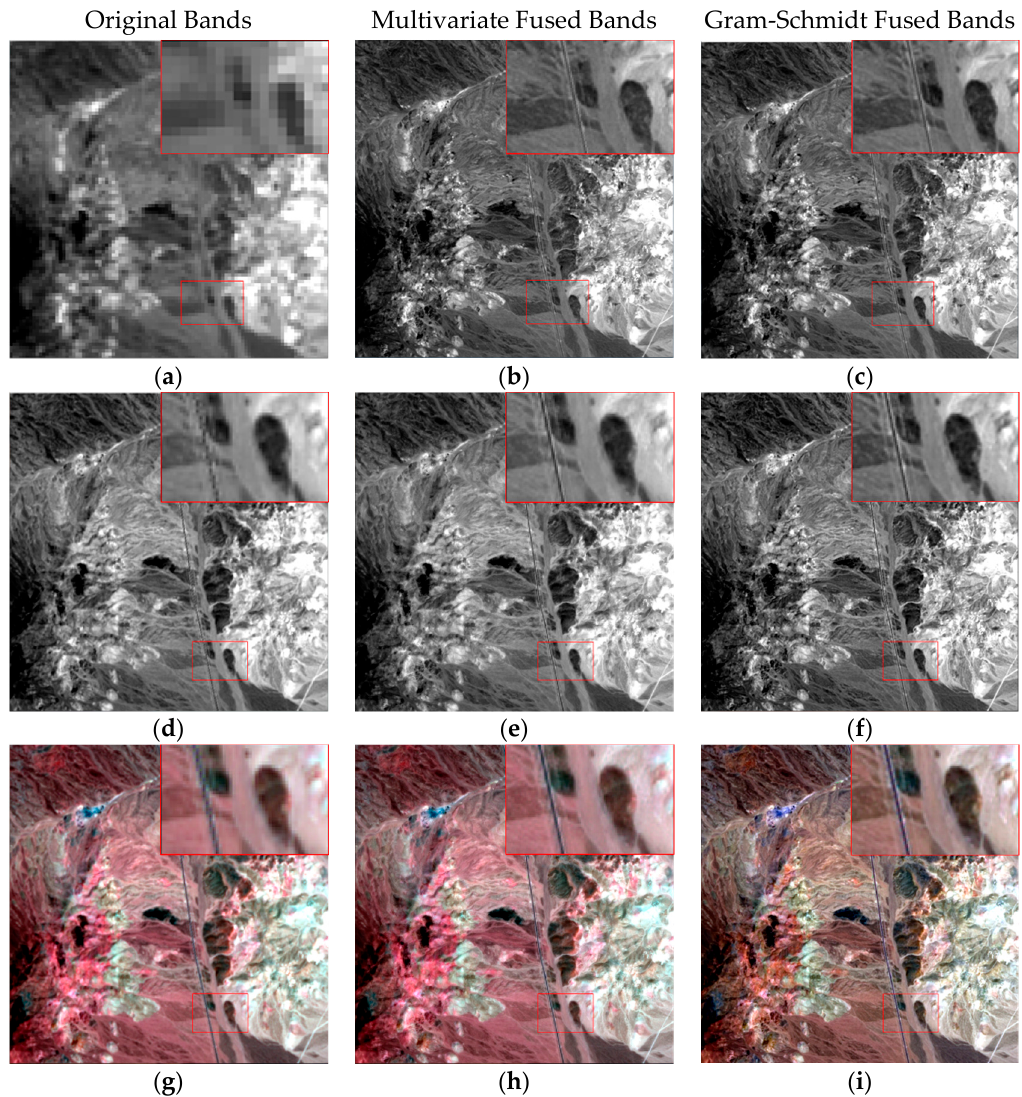
Figure 4. The original and fused Sentinel-2 bands. ( a ) Original 60 m MS60 1 band; ( b ) multivariate fused MS60 1 band; ( c ) Gram-Schmidt fused MS60 1 band; ( d ) original 20 m MS20 6 band; ( e ) multivariate fused MS20 6 band; ( f ) Gram-Schmidt fused MS20 6 band; ( g ) original 20 m bands (RGB: MS20 11 -MS20 8A -MS20 5 ); ( h ) multivariate fused 20 m bands (RGB: MS20 11 -MS20 8A -MS20 5 ); ( i ) Gram-Schmidt fused 20 m bands (RGB: MS20 11 -MS20 8A -MS20 5 ).